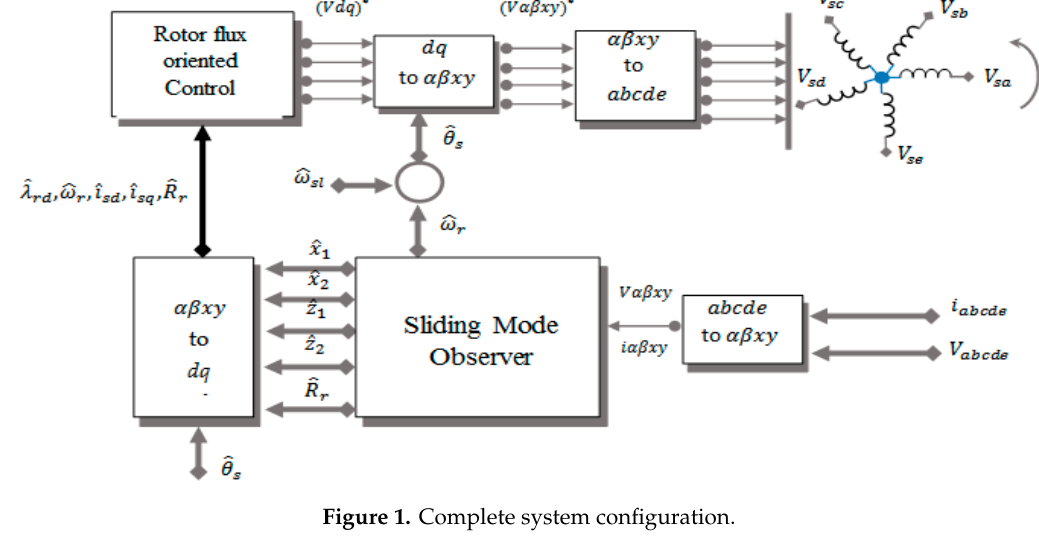
Figure 1. Complete system configuration.